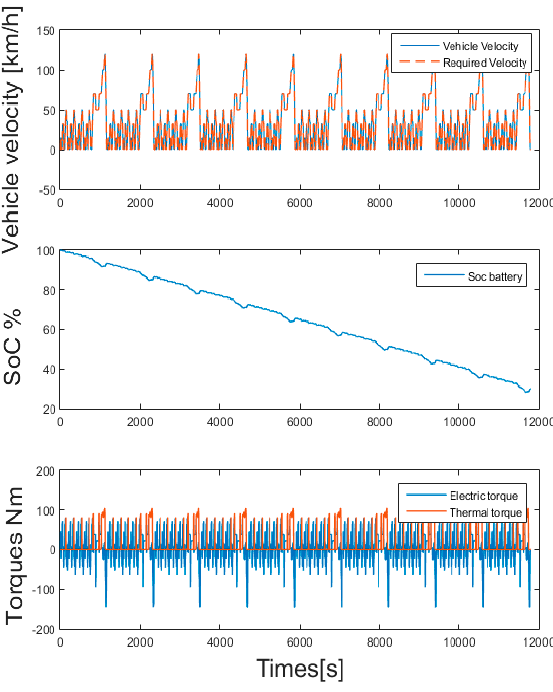
Figure 12. Validation of the proposed offline L-Control algorithm for PHEV during 10 NEDC cycles.